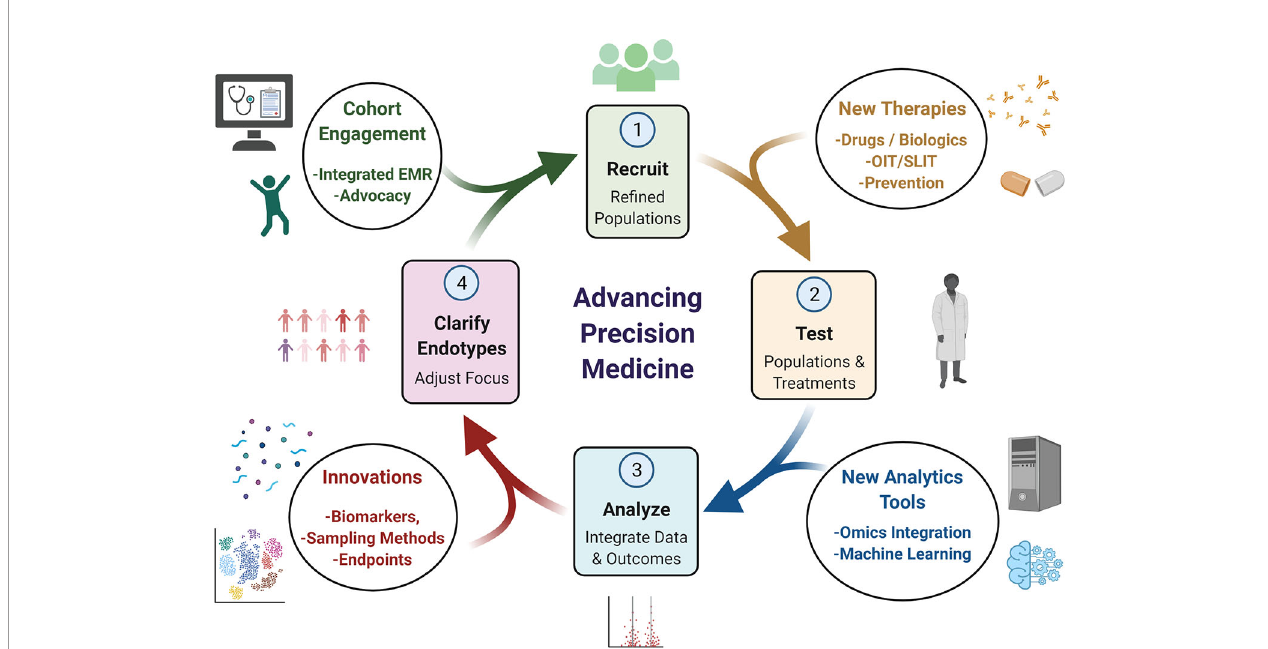
FIGURE 4 | Conceptual Cycle of Precision Medicine Advancement. Advancement of precision medicine depends on an iterative process of clarifying endotypes, recruiting new cohorts designed to re fi ne endotypes, which are then tested and analyzed. Innovations in biomarkers, improved sampling and new endpoints can offer new targets to study. Endotypes can be targeted more speci fi cally for tailored cohort generation with next generation EMR systems and engaging with patient advocacy groups. New drugs or other therapeutic strategies can also be tested with these re fi ned cohorts. Finally, integration of results and data tools can help re fi ne the next iteration of which endotypes could be focused on. These innovations can impact any